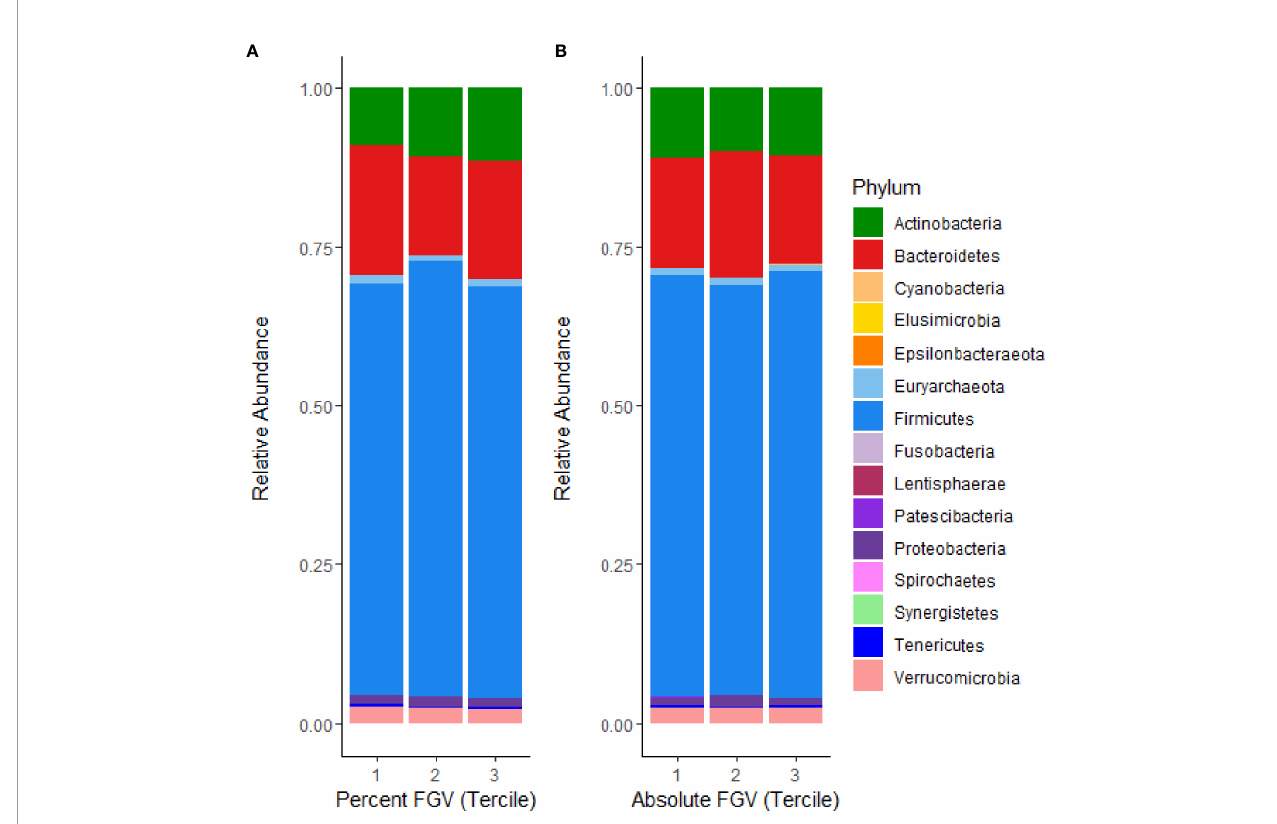
FIGURE 1 | Microbialmeanrelativeabundanceat thephylum levelstrati fi edby (A) %FGVtercileand (B) aFGVtercileinfecalmicrobiota samplesfrom